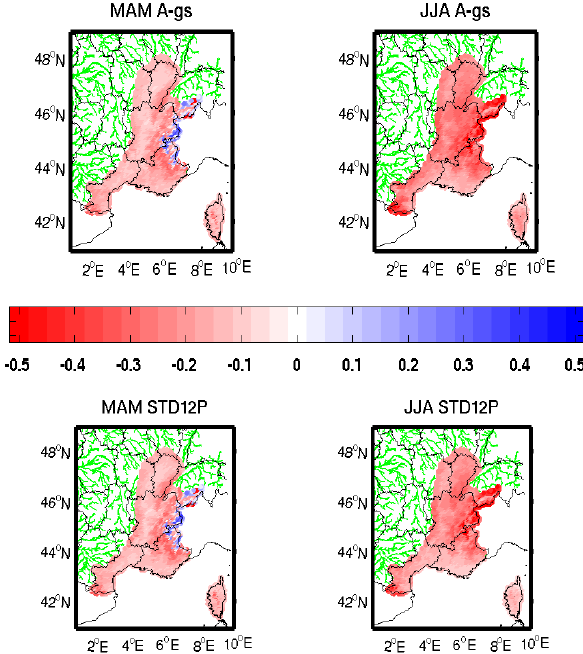
Figure 8: Anomalies of average seasonal SWI (March-April-May and June-July-August) 2 Fig. 8. Anomalies of average seasonal SWI (March-April-May obtained with ISBA-A-gs (top) and ISBA-Standard (bottom) with the CYPRIM scenario for 3 and June-July-August) obtained with ISBA-A-gs (top) and ISBA- both. The anomalies are calculated by comparing two periods: 2069-2099 vs 1970-2000. 4 Standard (bottom) with the CYPRIM scenario for both. The anoma- lies are calculated by comparing two periods: 2069–2099 vs. 1970–